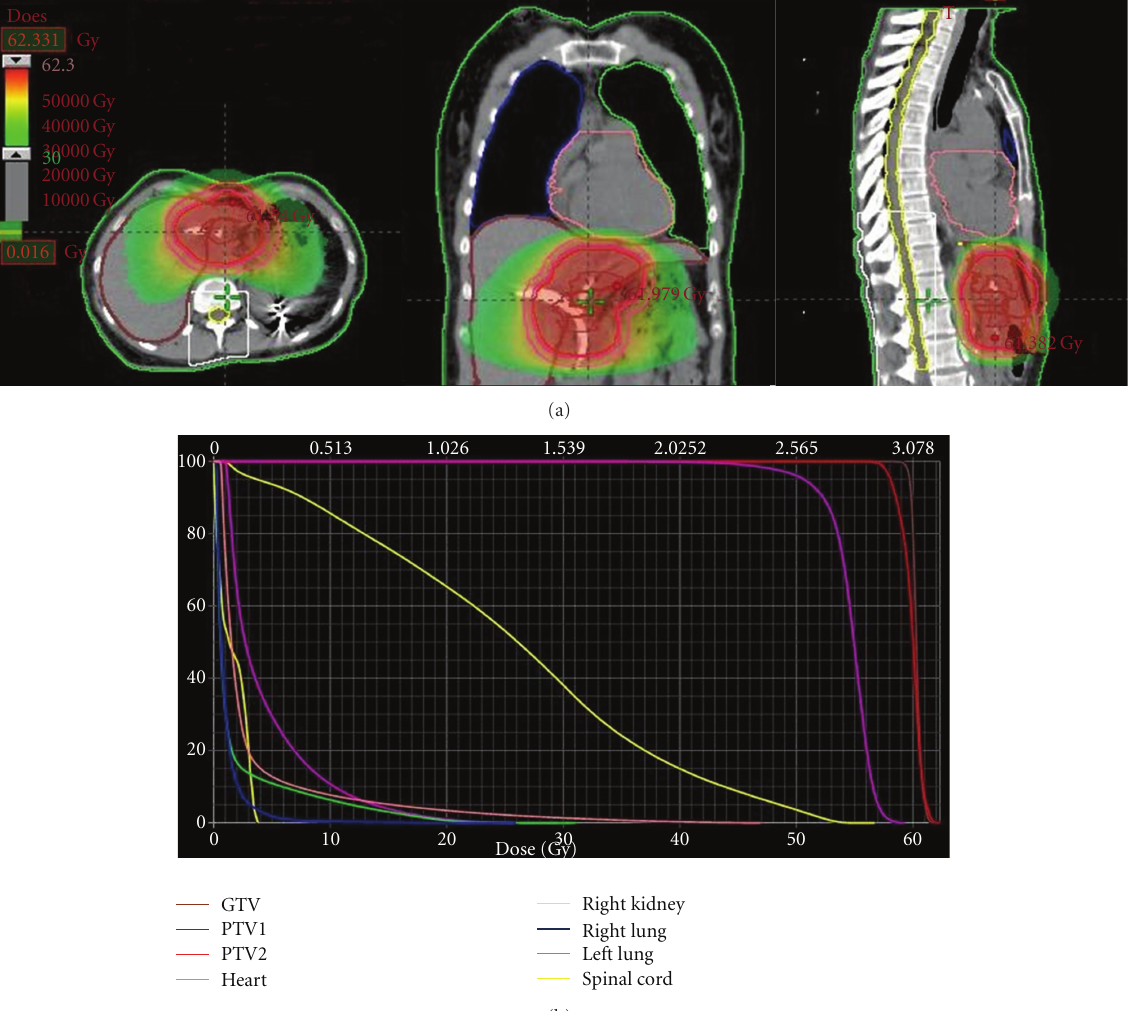
Figure 2: Distribution of isodoses with HT treatment planning in the patient 9 (cholangiocarcinoma) and the corresponding dose-volume histogram. The di ff erent doses as well as the target volumes/organs at risk are represented with di ff erent colors. Red color represents the target volume dose ( > 54Gy). Green color represents lower radiation doses of 30Gy.